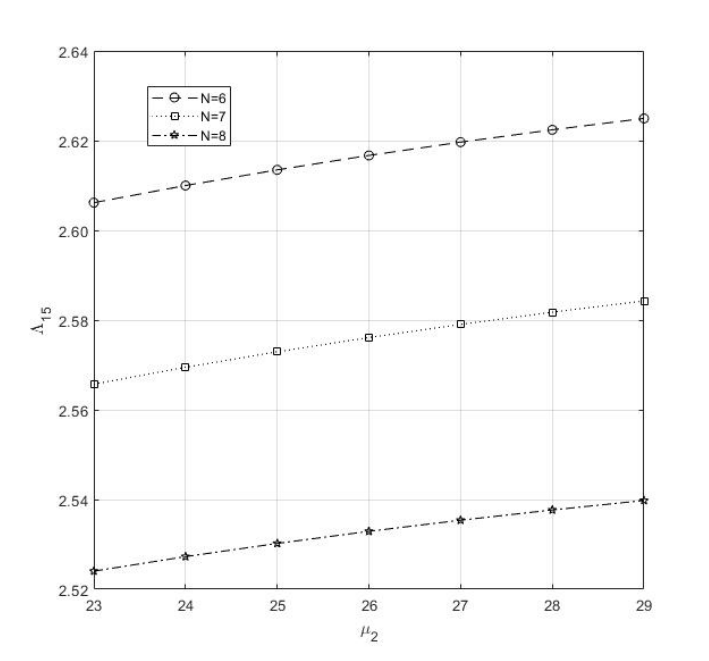
Figure 12. Mean number of Type-II Idle server of N vs. µ 2 .